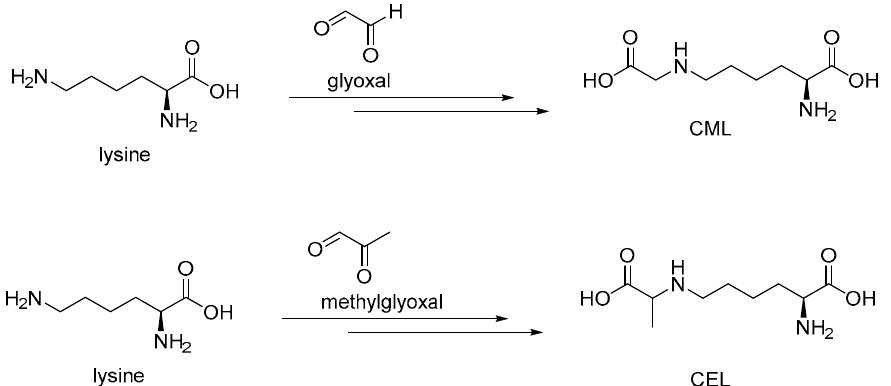
Figure 4. Formation CML and CEL through Maillard reactions.